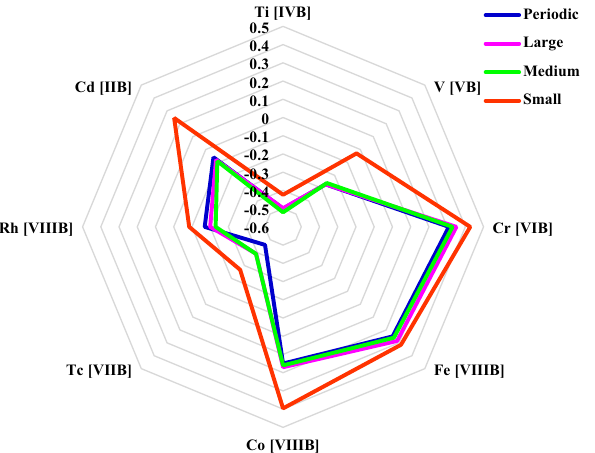
Figure 4. Comparison of hydrogen adsorption energy for different sizes of metal/NC